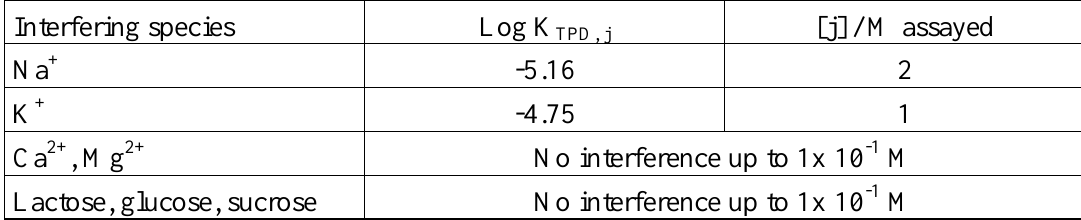
Table 3. Selectivity coefficients.